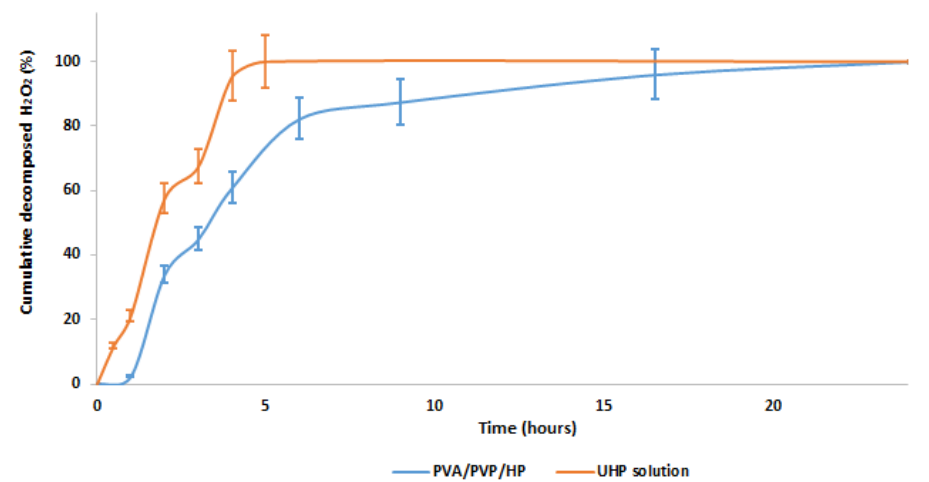
Figure 9. HP decomposition over time in PVA/PVP/HP hydrogel (blue) and aqueous UHP solution (orange).